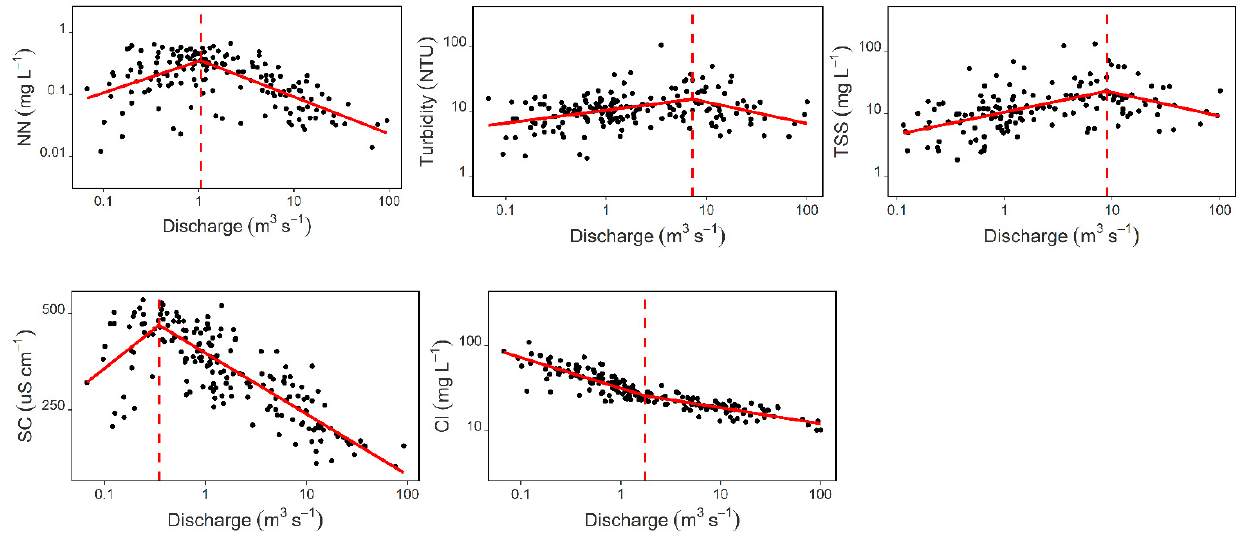
Figure 5. Concentration–discharge ( C–Q ) relationship plots for water quality constituents with discharge thresholds at PRB.